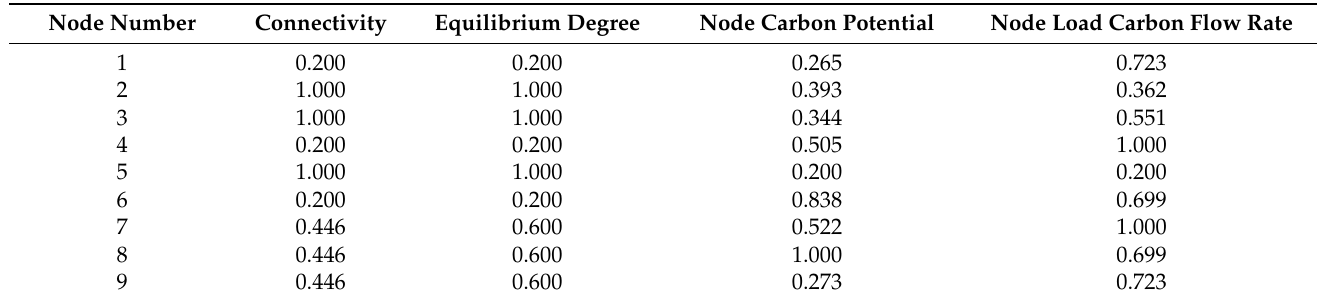
Table 6. Normalized carbon emission flow importance